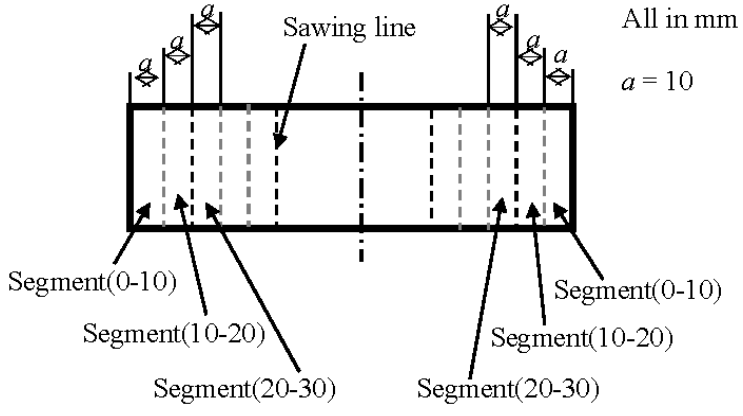
Figure 4. Specimen sawn into segments after soaking in sodium chloride solution over 90